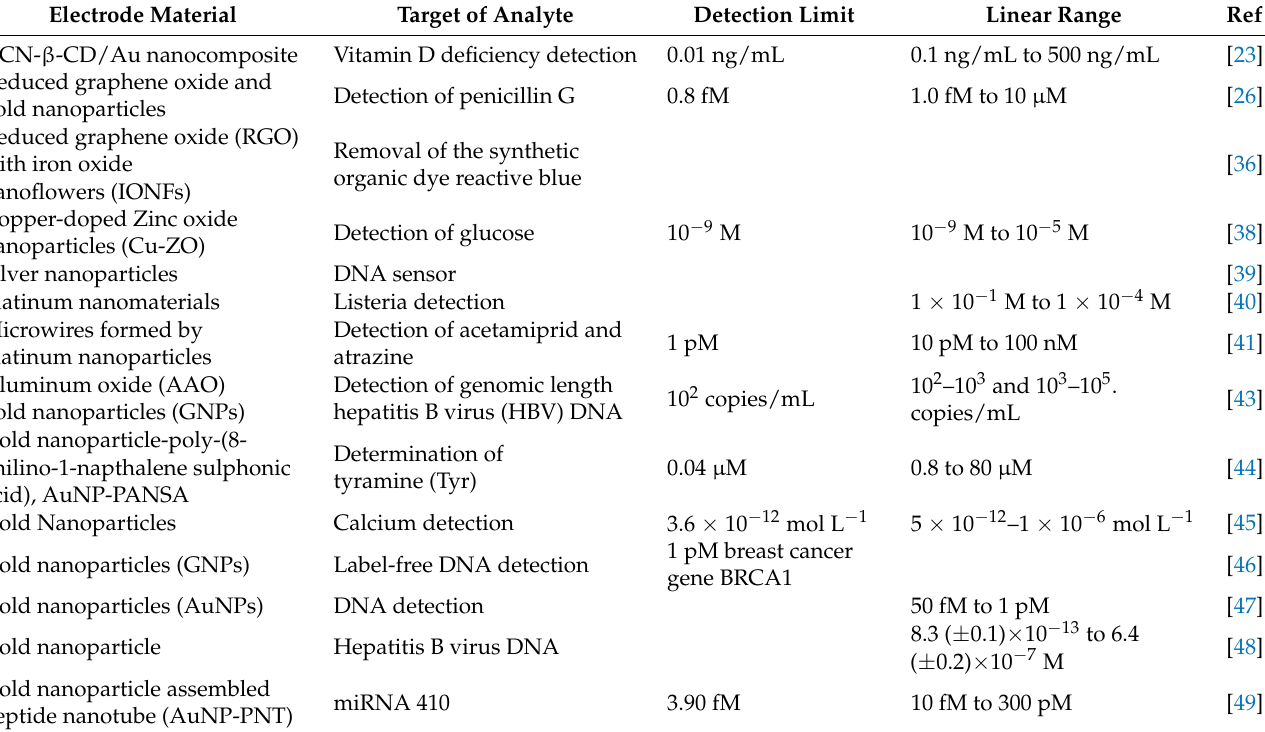
Table 1. A summary of the reported materials for target analysis using the